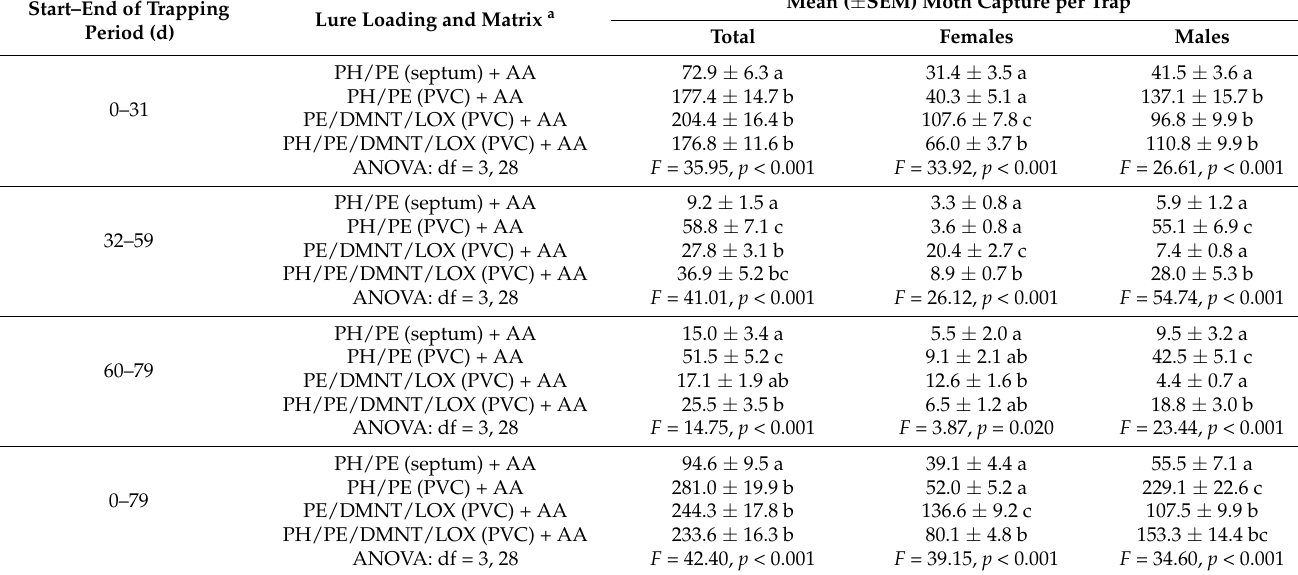
Table 1. Mean ( ± SEM) cumulative captures of codling moths in traps baited with four different combinations of ( E , E )- 8,10-dodecadien-1-ol (sex pheromone, PH), ( E , Z )-2,4-ethyl decadienoate (pear ester, PE), ( E )-4,8-dimethyl-1,3,7-nonatriene (DMNT), and linalool oxide (LOX) loaded into either an elastomer septum or a PVC matrix, and used in combination with a closed membrane lure loaded with acetic acid (AA), (N = 8) over three consecutive time periods from 4 May to 22 July 2019,